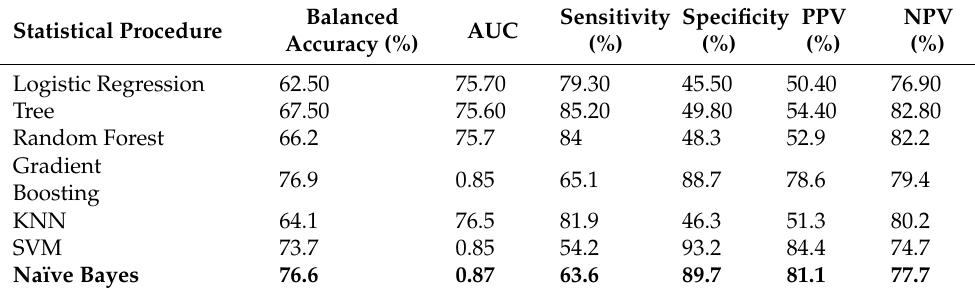
Table 2. Machine learning models and performance in nested cross-validation.